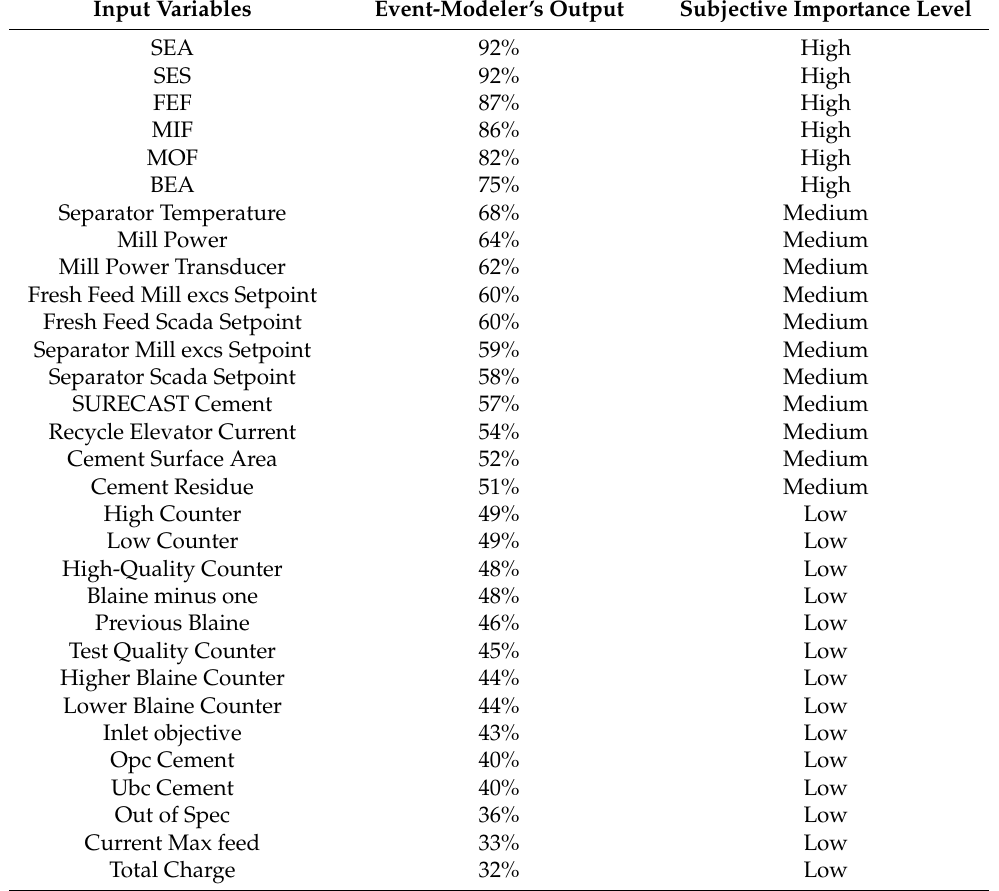
Table A1. Event-Modeler output between the mill and separator parameters and coarse